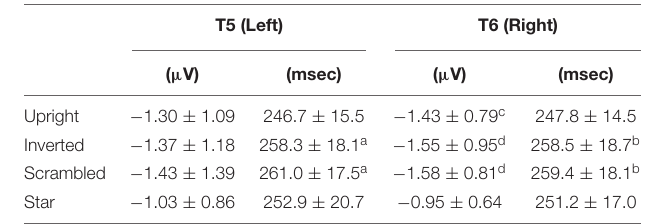
TABLE 4 | The peak latency and maximum amplitude of N-ERP250 at T5 and T6 (the temporal area).